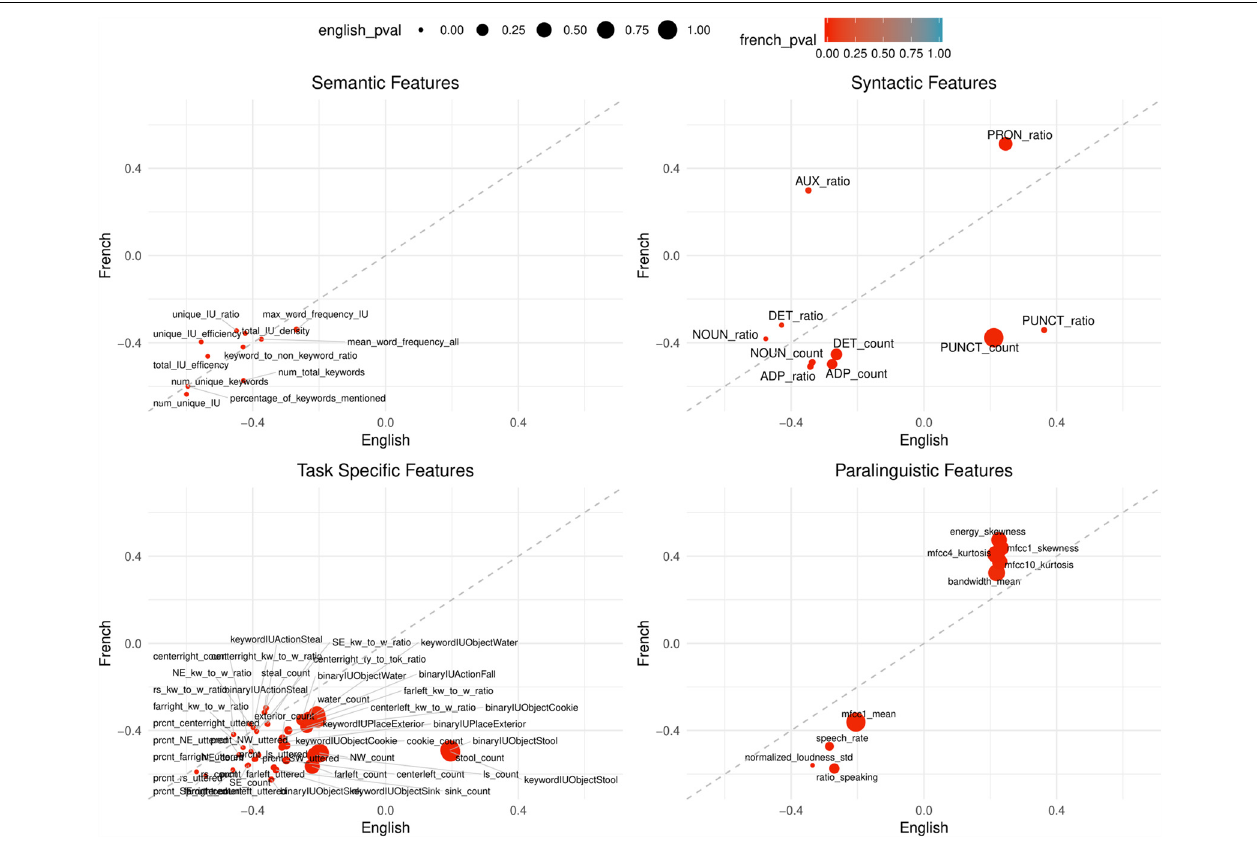
FIGURE 3 | Points are plotted by correlation values (point-biserial correlation coefficient r PB , correlating the feature with the group AD vs. HC) with French on the Y-axis and English on the X-axis for each feature subgroup. The significance value (as by Kruskal–Wallis non-corrected significance test p < 0.05) is visualized by point color for French and point size for English. Points closer to the dashed line perform equally well in both languages. This figure contains all features that are significant in BOTH French AND English. Feature labels are added to each